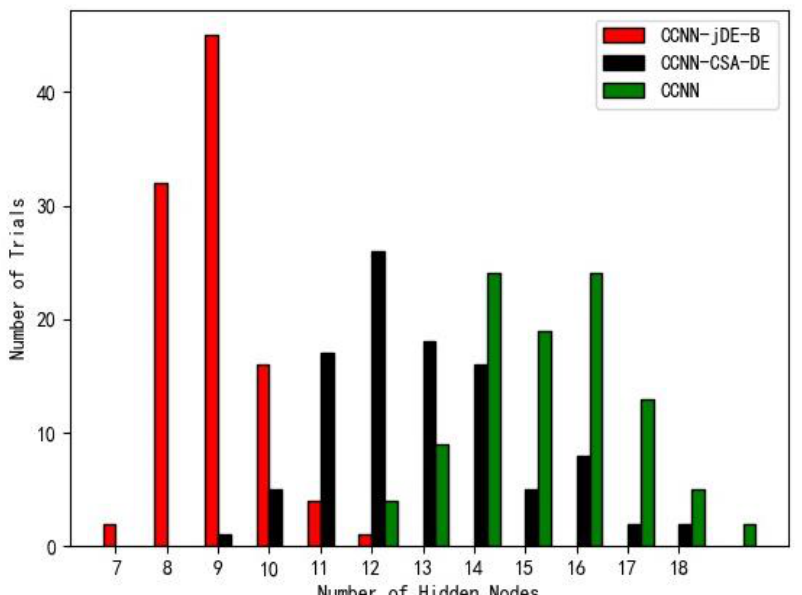
Figure 6. Distribution of the number of hidden units of each algorithm on the two spirals classification problem.